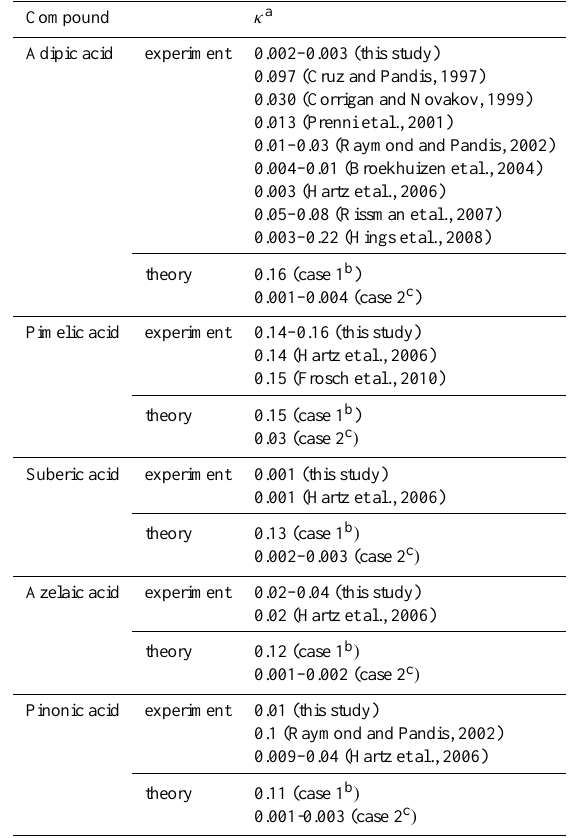
Table 3. Values of single parameter κ for organic compounds tested in this study. Raw data are presented in the